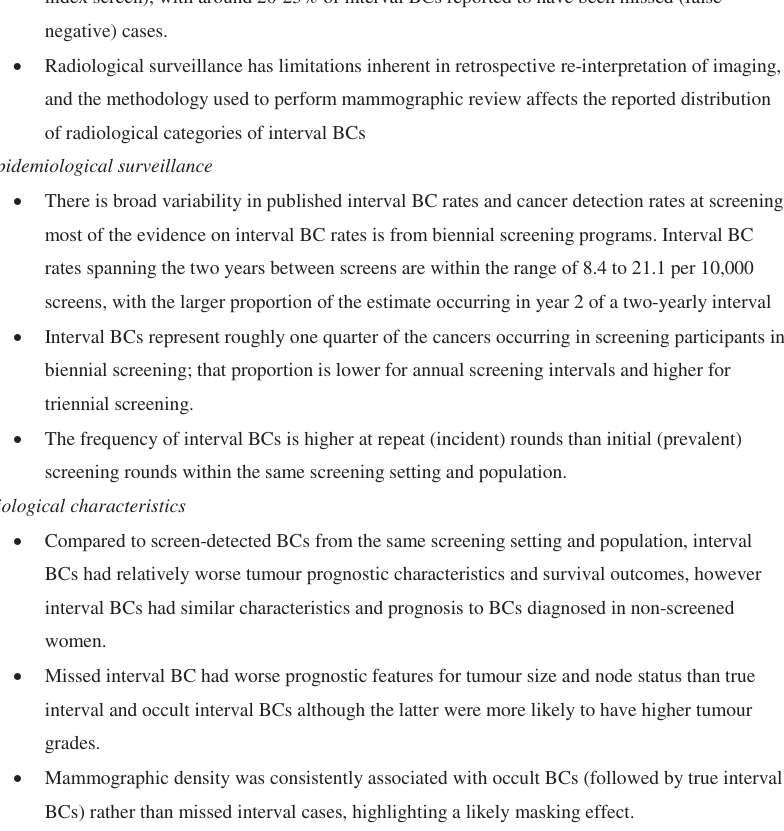
Fig. 2 Key fi ndings of the